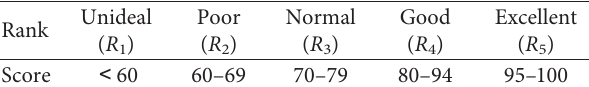
Table 5: Classification